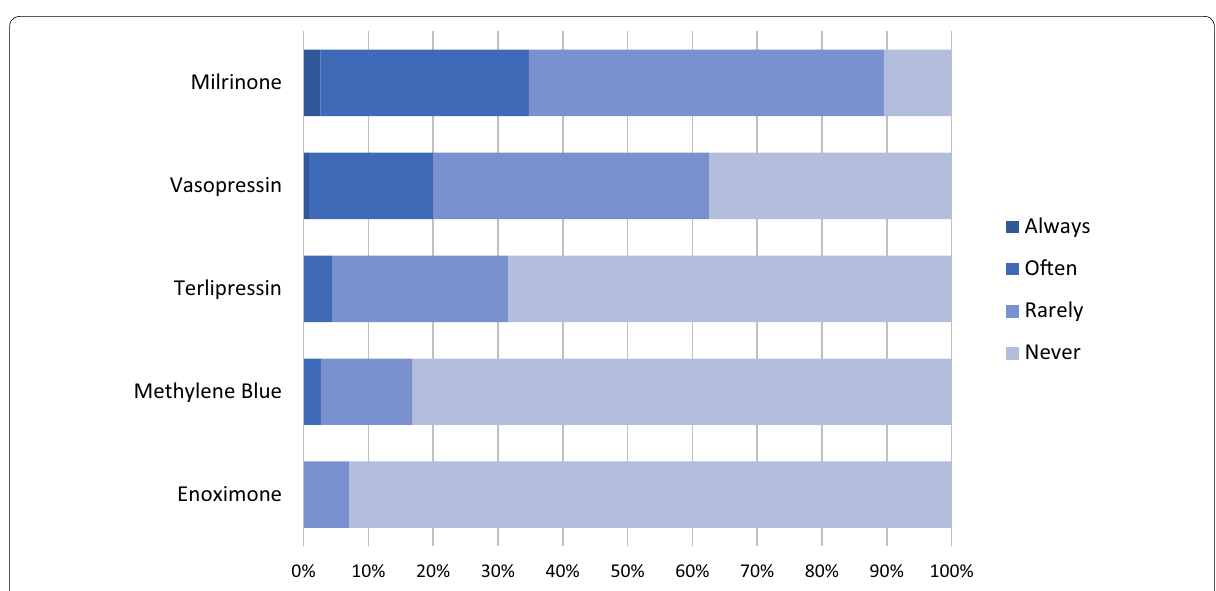
Fig. 1 Declared use of adjunct therapies in pediatric septic shock children